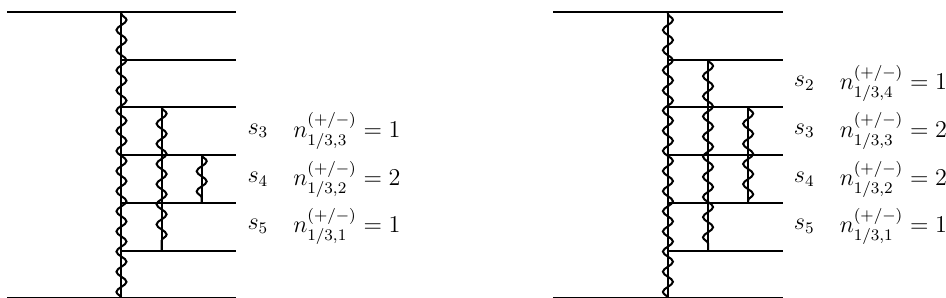
Figure 8 . Left: the three-Reggeon bound state is described by an additional Reggeon in the corresponding t -channel. We study the three-Reggeon bound state connected to the t Such a bound state can only appear if the number of Reggeons in neighboring channels differs by at most one, which is satisfied by the shown configuration of crossing singularities. The figure also shows the number n (+ / − ) of crossing singularities which occur in the corresponding channels. 1 / 3 ,s Right: a configuration in which the three-Reggeon bound state appears in both the t channel. Again the associated crossing singularities are illustrated.